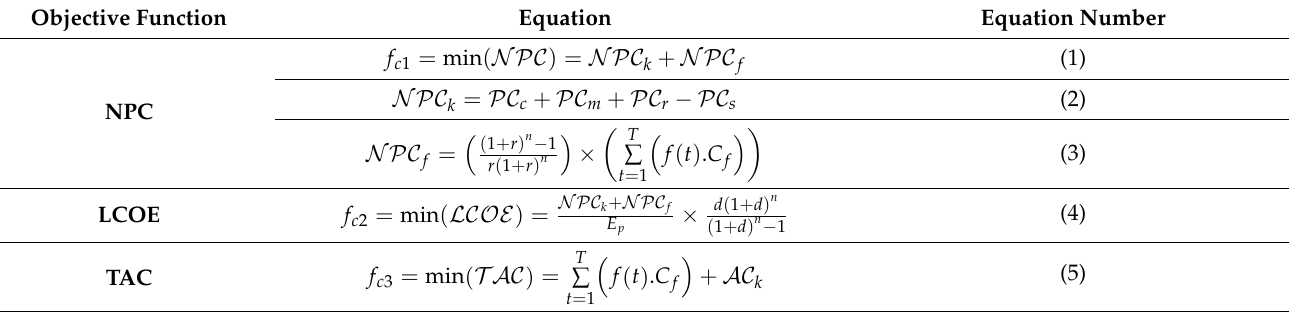
Table 1. The mathematical formulation of financial objective functions for the RAES optimal planning problem. Objective Function